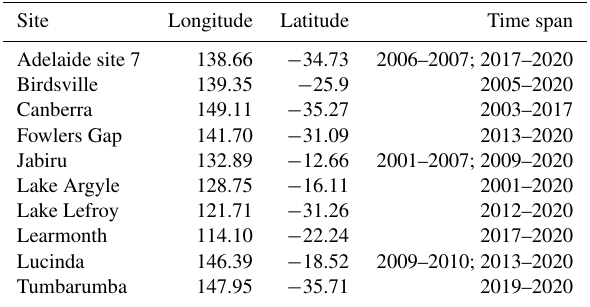
Table 1. Site location and data time period at each site used in this